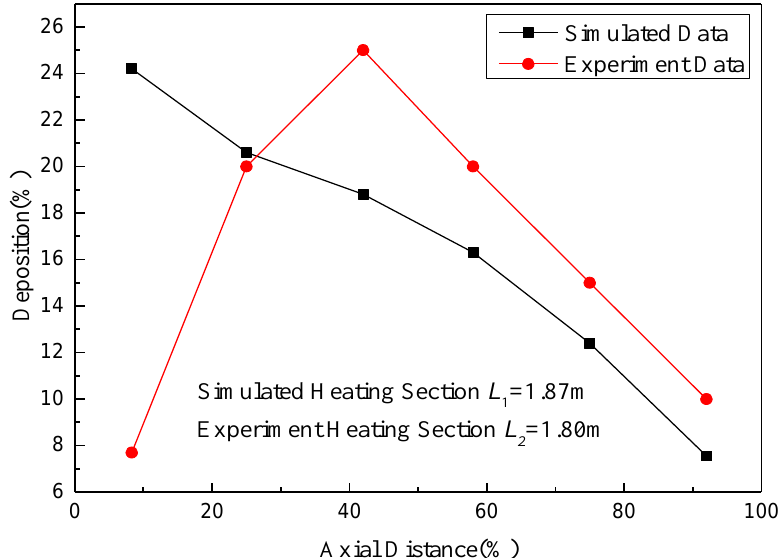
Figure 15. Comparison of simulated calculation data with experimental data.